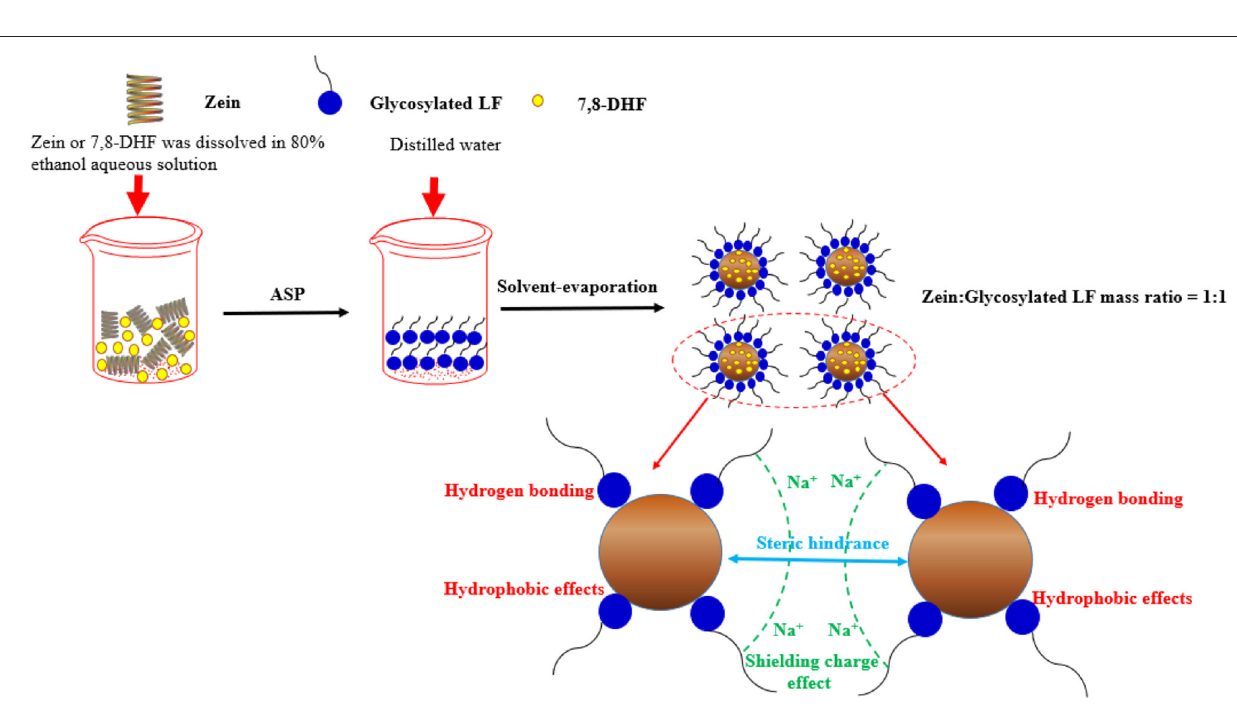
was loaded within the zein-hyaluronic acid binary